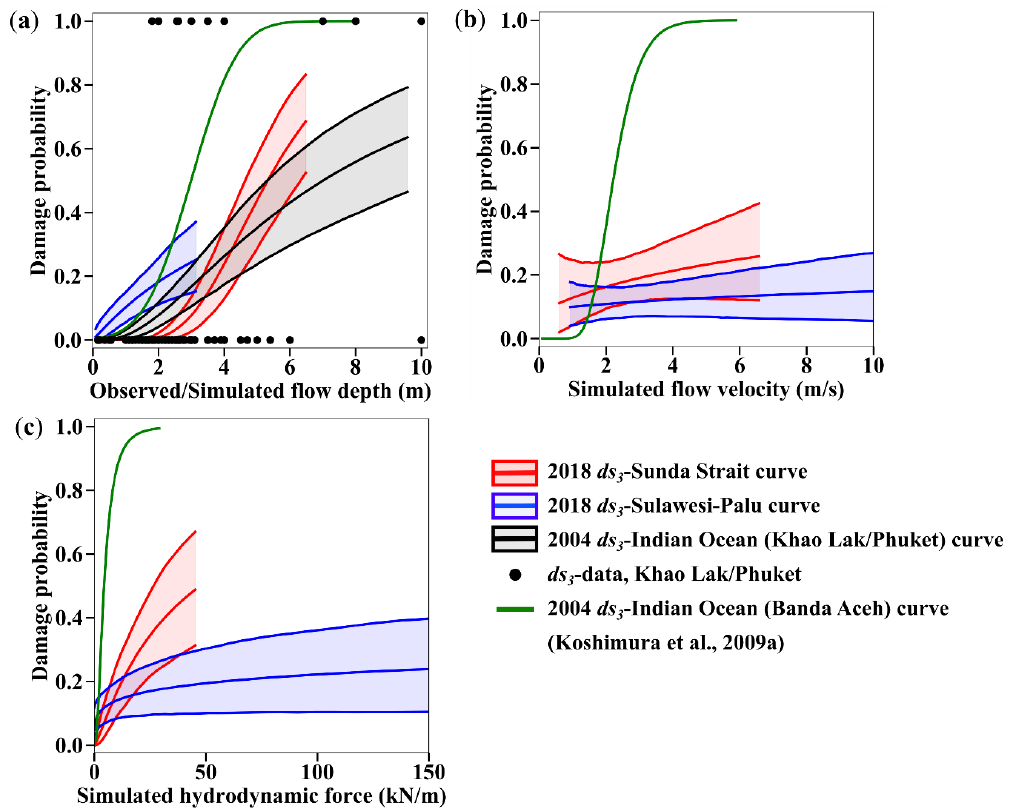
Figure 16. Best-estimate fragility curves for the 2018 Sunda Strait tsunami, 2018 Sulawesi–Palu tsunami, and 2004 IOT in Khao Lak–Phuket (Thailand) and Banda Aceh (Indonesia) as functions of (a) the observed and the maximum simulated flow depths, (b) the maximum simulated flow velocity, and (c) the simulated hydrodynamic force. These fragility functions are developed only for completely damaged or washed away buildings with their 90% confidence intervals.